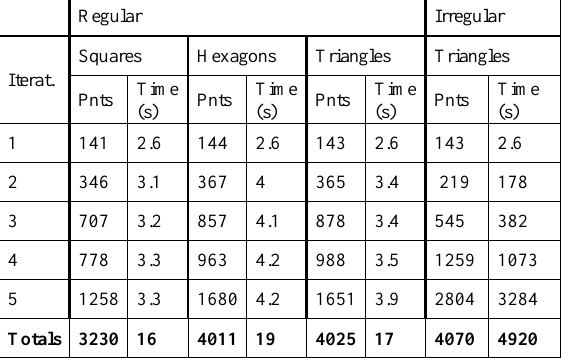
Figure 14. Delaunay triangulation of the DTM resulting points In Figure 14 b) is presented the exact same points that in Figure 14 a), therefor the triangulation was made using the